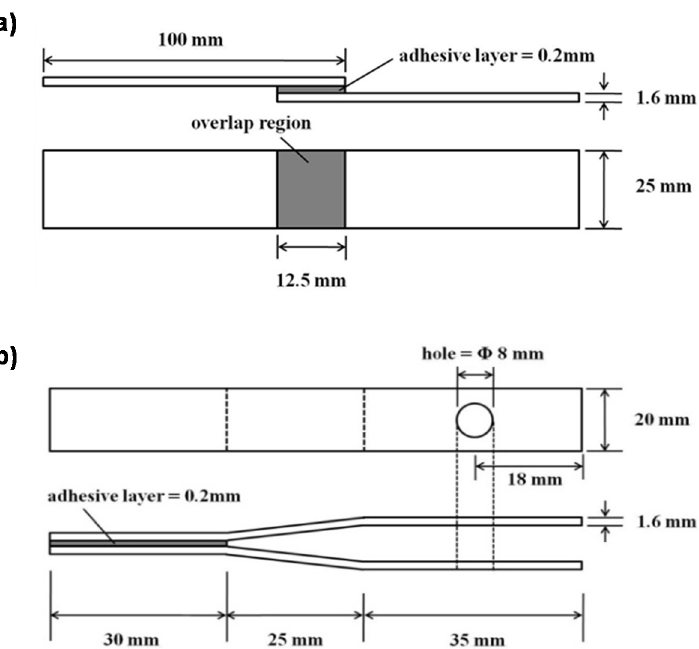
Figure 1. The specimens for ( a ) the lap shear strength test (ASTM D 1002) and ( b ) the impact peel strength test (ISO 11343).